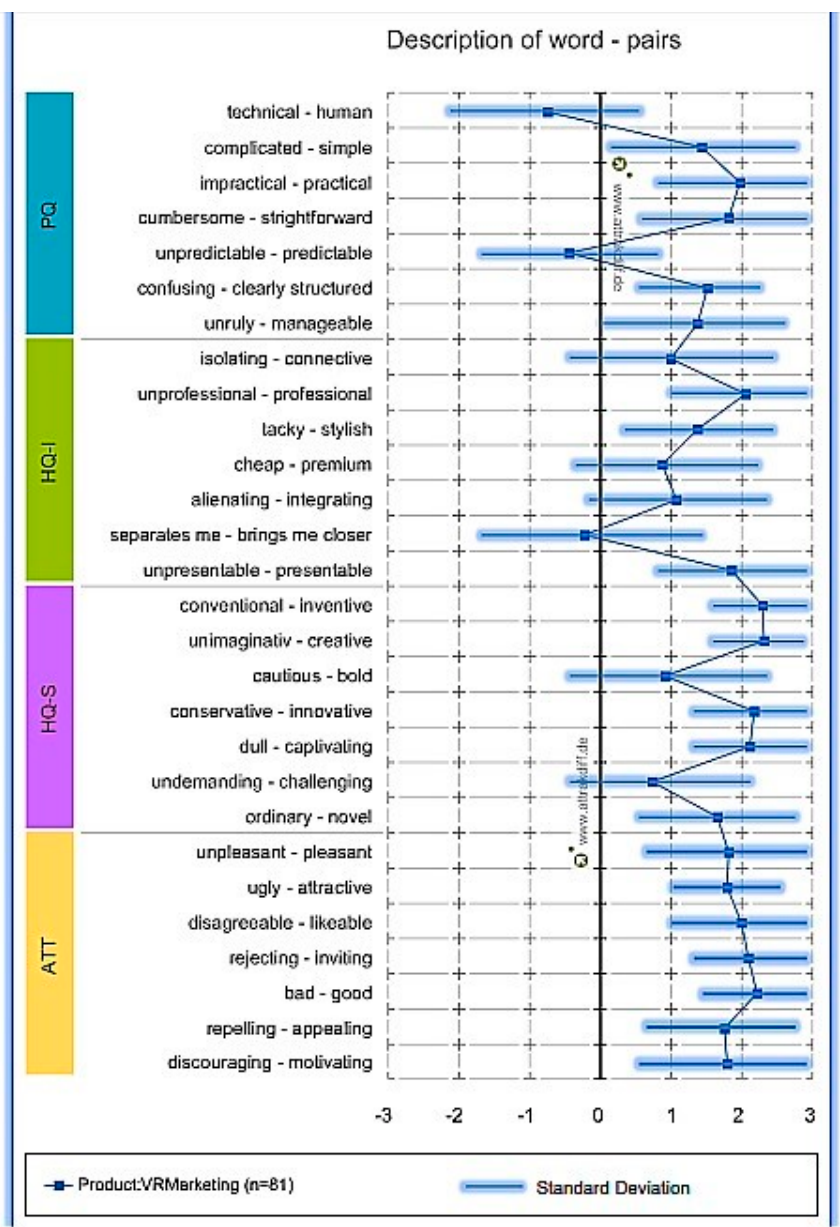
Figure 8. AttrakDiff Individual Results for each dimension.